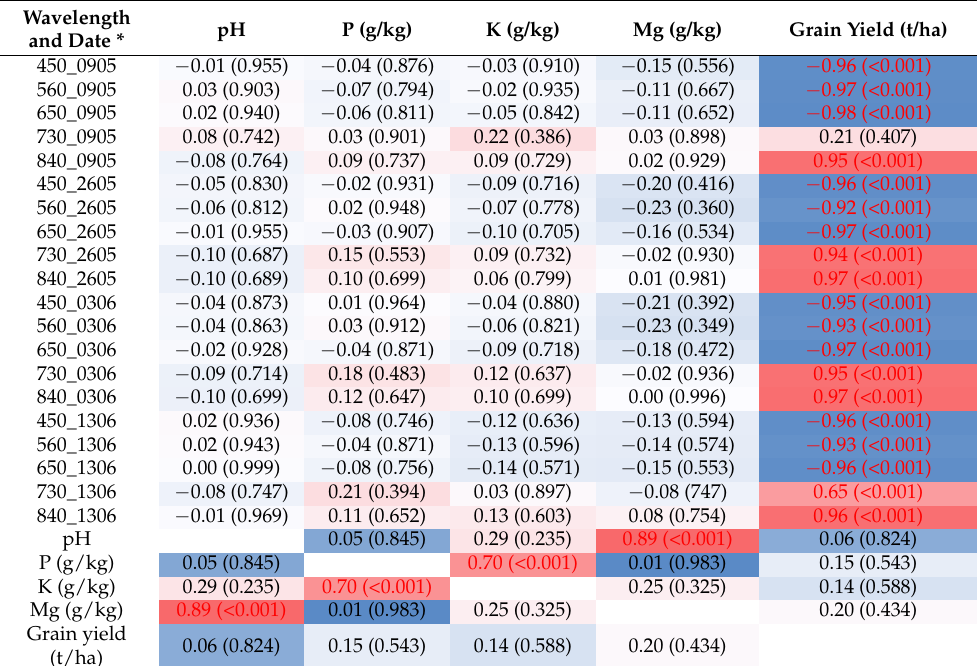
Table 7. Correlation coefficients (and p -values) between spectral reflectance and soil pH, available nutrients, and grain yield for the treatments in experiment 1 (crop rotation). Significant correlations ( p < 0.05) are in red